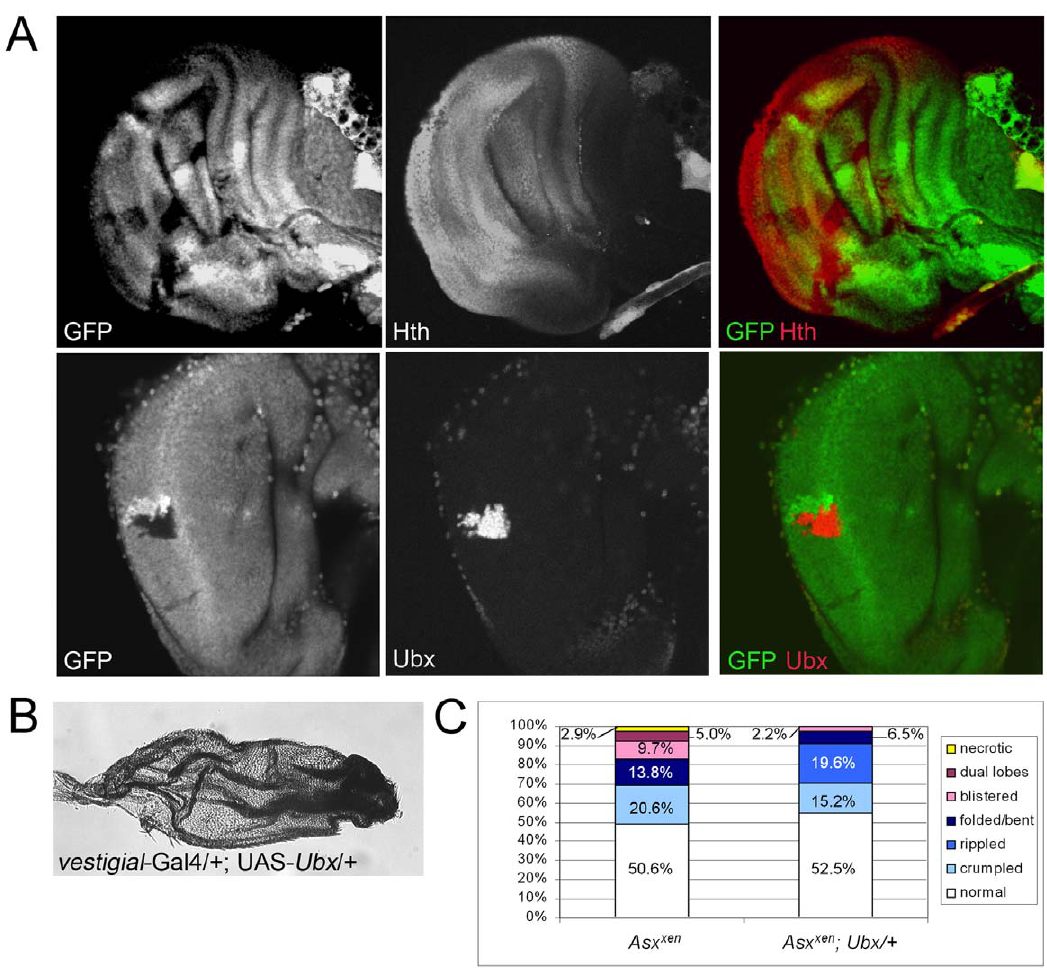
Figure 5. The primary defect in Asx mutants is upregulation of Ubx . A) Larval wing discs bearing Asx xen mutant clones (lacking GFP, green) were immunostained stained with anti-Hth (top) or anti-Ubx (bottom). Hth is expressed in the presumptive wing hinge in wild-type larval wing discs, and no effect is seen on Hth expression in Asx mutant clones. Ubx is expressed ubiquitously in haltere cells in imaginal discs, but is not normally expressed in wild-type wing blade cells. Ubx expression is strongly up-regulated within Asx mutant clones. B) Expression of UAS- Ubx throughout the wing blade using vestigial -Gal4 leads to wing defects that are indistinguishable from those seen in Asx mutant clones. C) Quantitation of wing phenotypes associated with Asx xen mutant clones in flies that are wild-type at the Ubx locus (column 1, N=383) or heterozygous (column 2, N=46). Phenotypes are shown in order of increasing severity from bottom to top. Reduction of Ubx levels partially suppresses Asx xen defects.